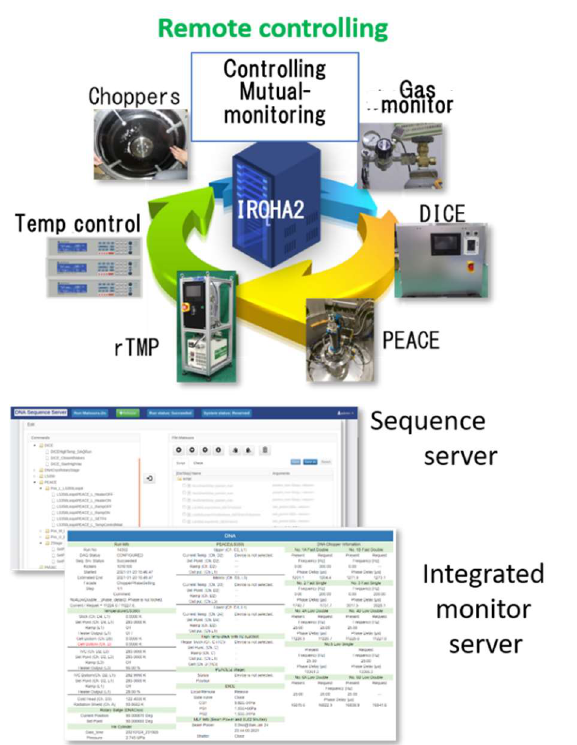
Fig. 9. Remote controlling way at DNA on the software framework IROHA2[13]. From the sequence server, command lists according to timeline of experiment can be conducted remotely. All status of devices is watched by the integrated monitor